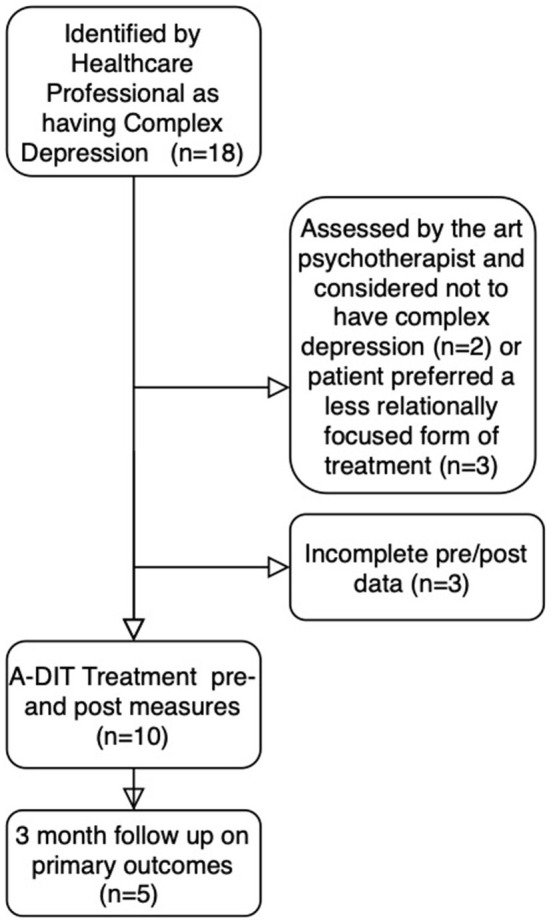
Consort diagram.